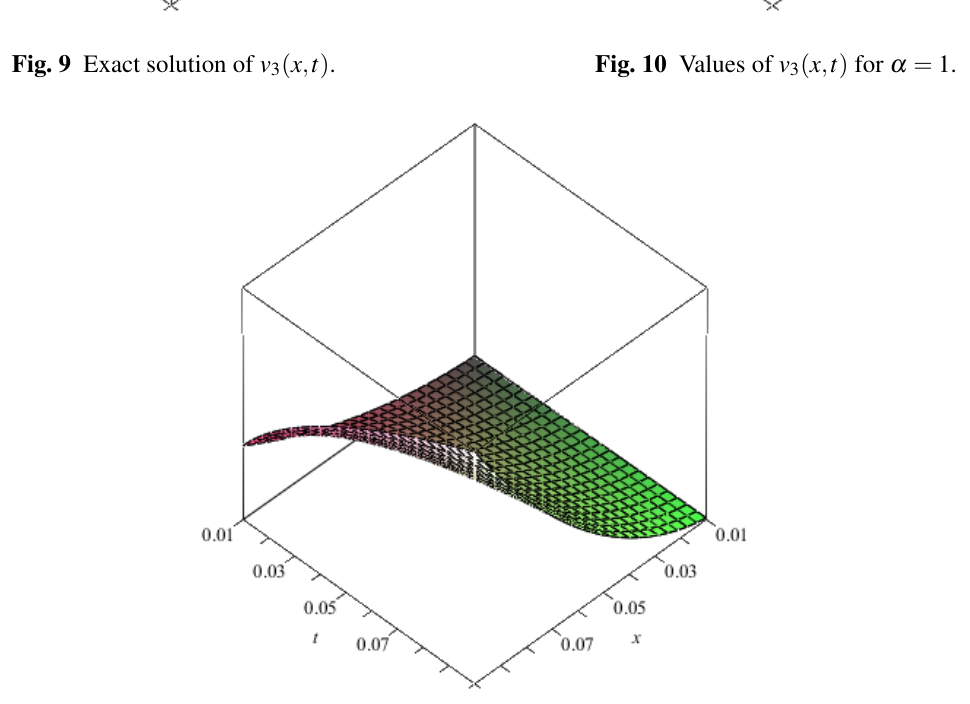
Fig. 11 Values of v 3 ( x , t ) for α = 0 .